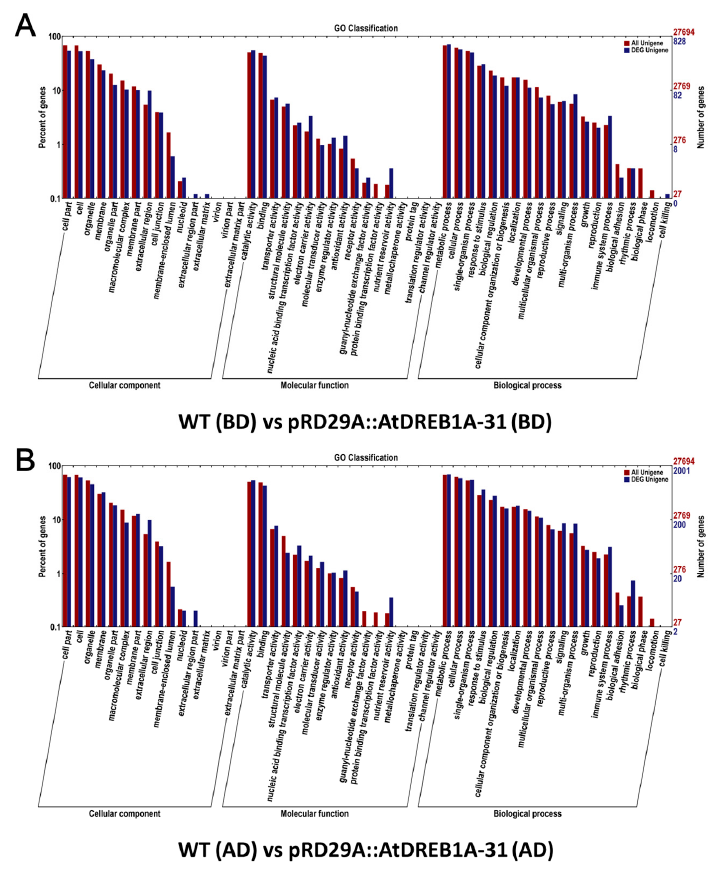
Figure 4. Functional Gene Ontology (GO) term classifications of DEGs in the comparisons between WT and AtDREB1A transgenic plants before and after drought treatment. ( A ) WT (BD) versus pRD29A::AtDREB1A-31 (BD); ( B ) WT (AD) versus pRD29A::AtDREB1A-31 (AD). WT, wild type; pRD29A::AtDREB1A-31, pRD29A::AtDREB1A transgenic line 31. BD, before drought; AD, after six days of drought.